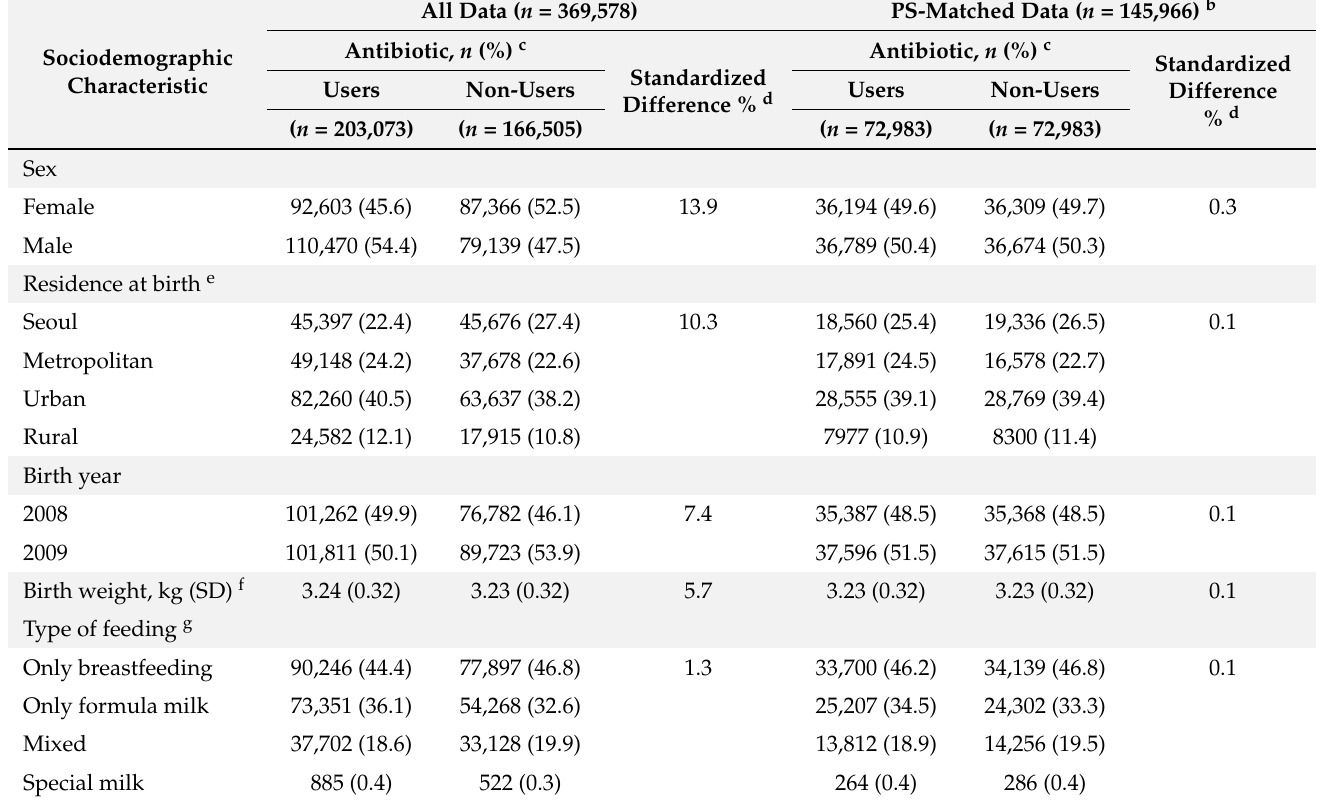
Table 1. Basic sociodemographic characteristics of children in the main cohort a